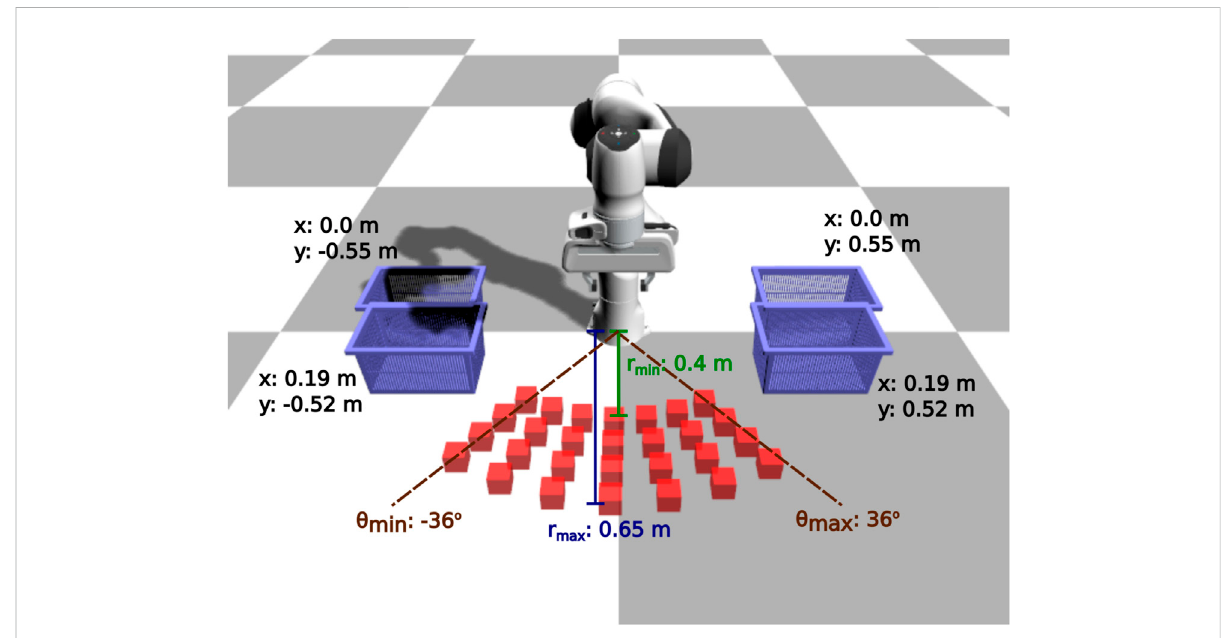
FIGURE 3 Pick and place task: evaluation con fi gurations. We use 112 different initial con fi gurations to evaluate the learned policies: 28 different box positions for 4 different basket